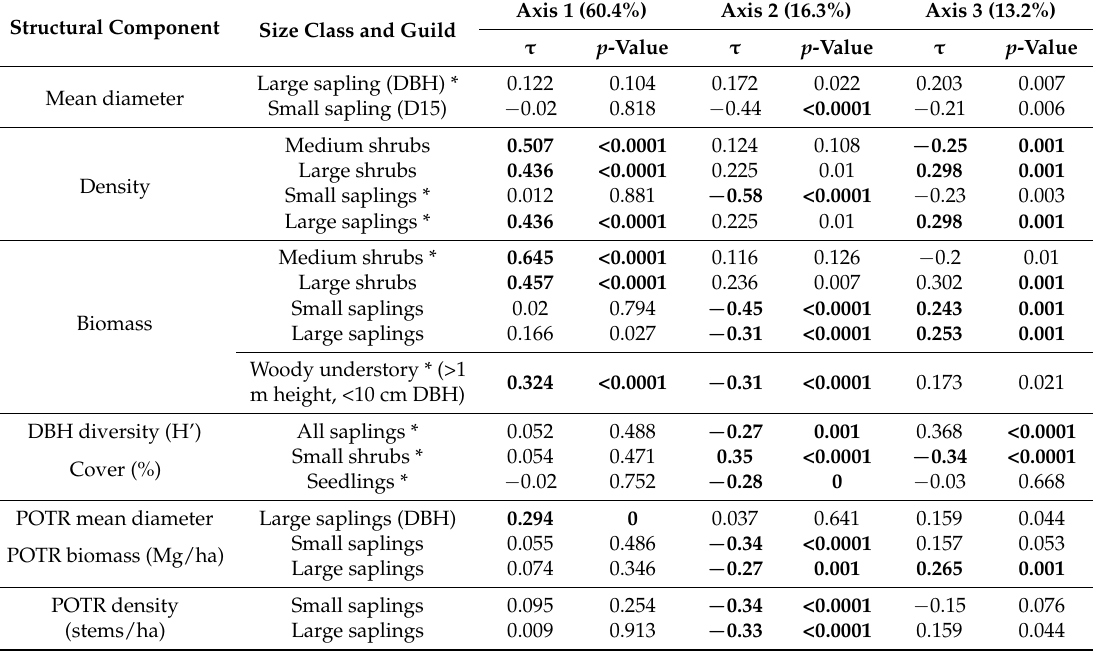
Table 1. Kendall’s tau ( τ ) correlation for understory forest structural components and non-metric multidimensional scaling (NMS) axes. Percentages in parentheses for each axis indicate the variability